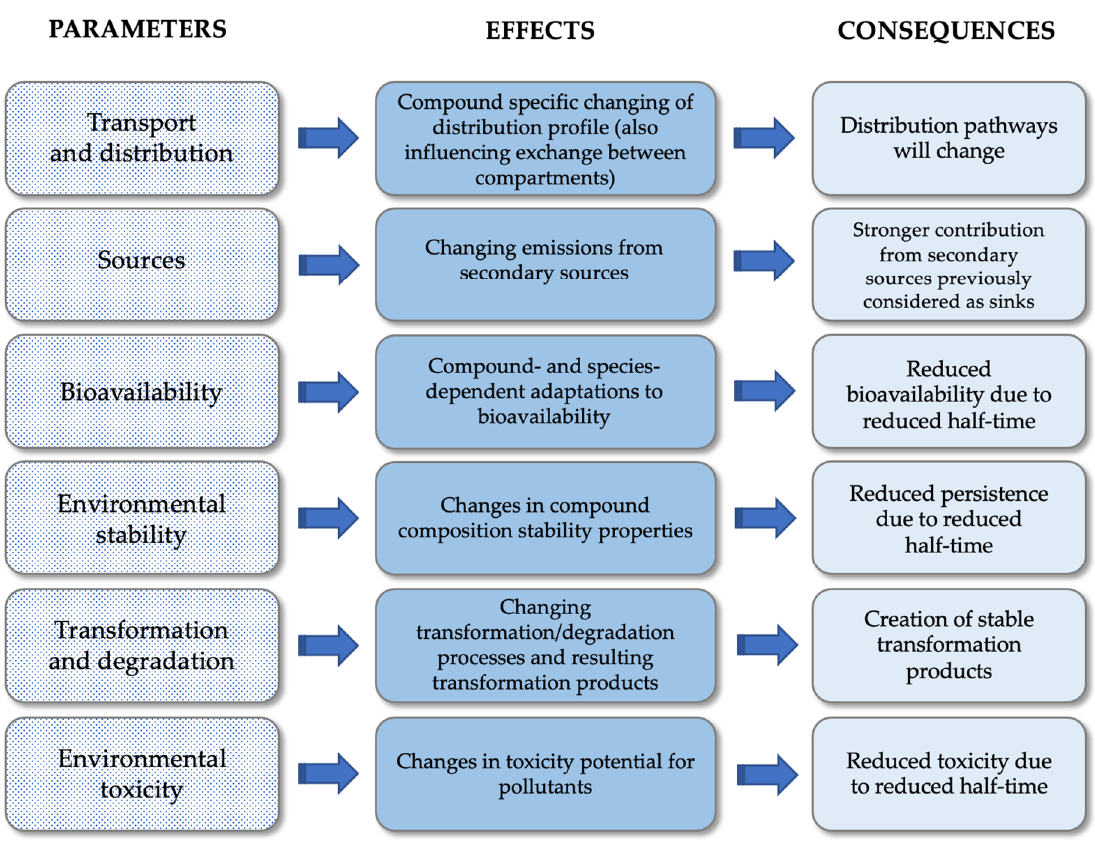
Figure 4. Expected effects of climate change on environmental processes related to transport and distribution of POPs [20,104].